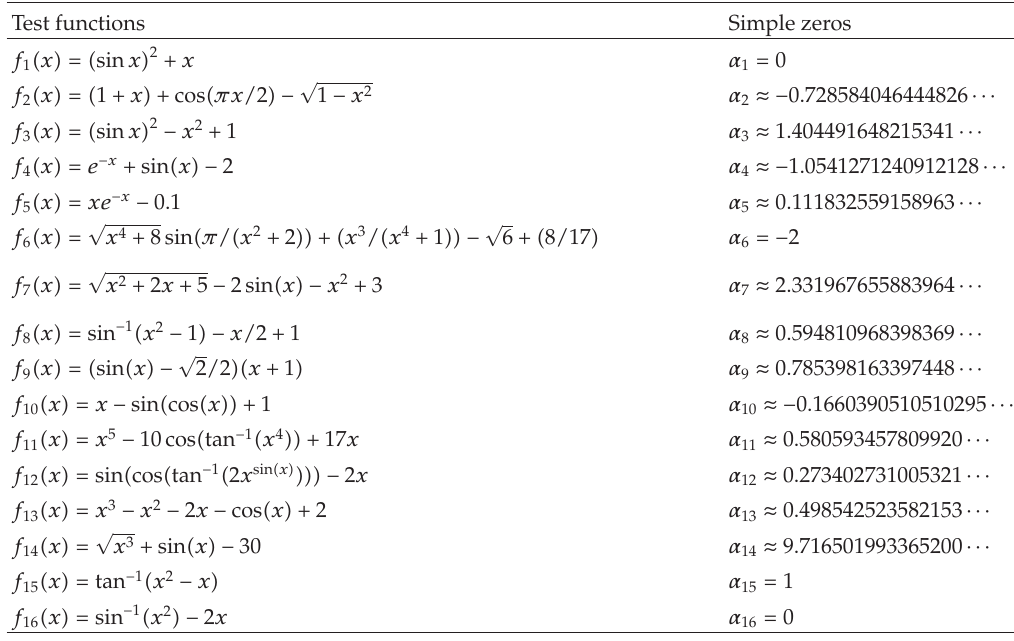
Table 1: The examples considered in this